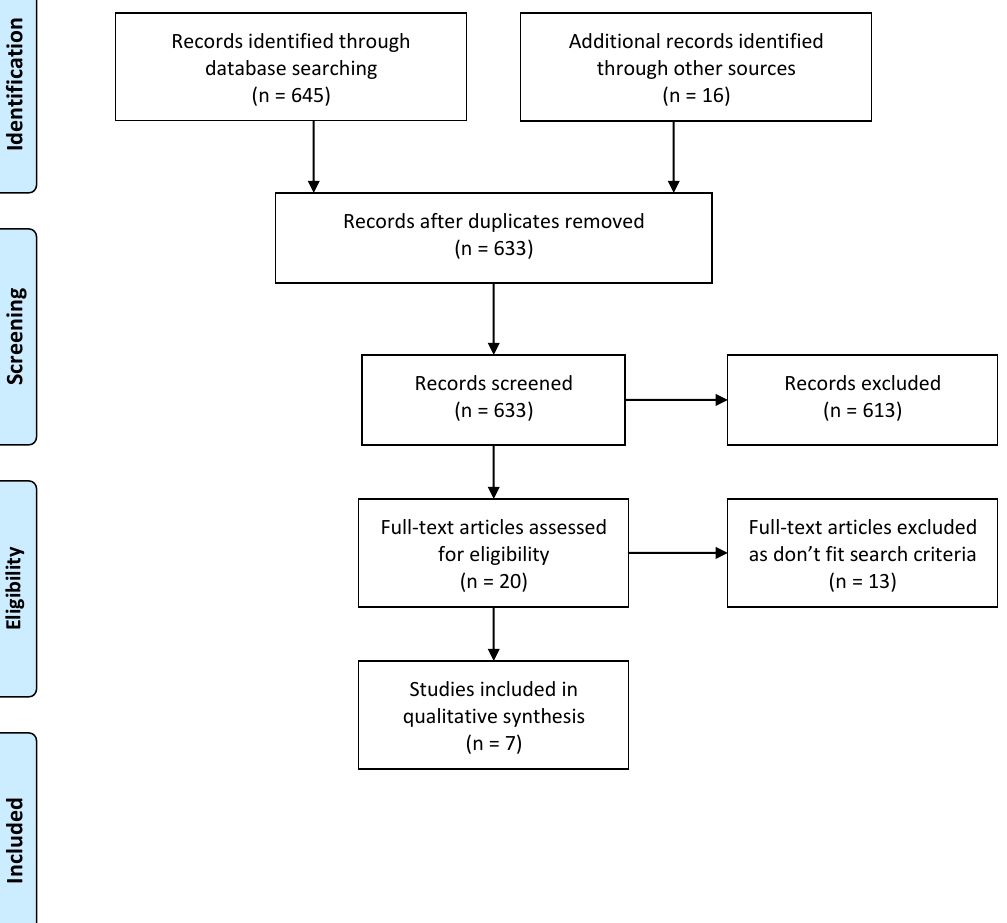
Figure 1. Study selection